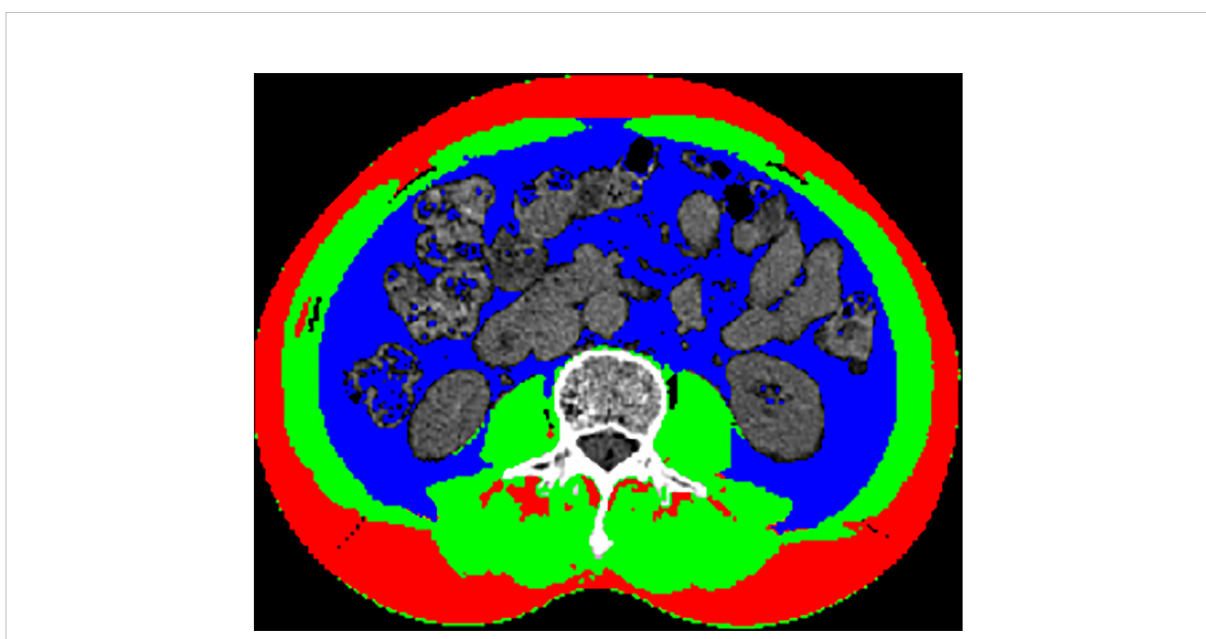
FIGURE 1 Representative CT image of the skeletal muscle area at L3 level: (Green) skeletal muscle; (Blue) visceral adipose tissue; (Red) subcutaneous adipose